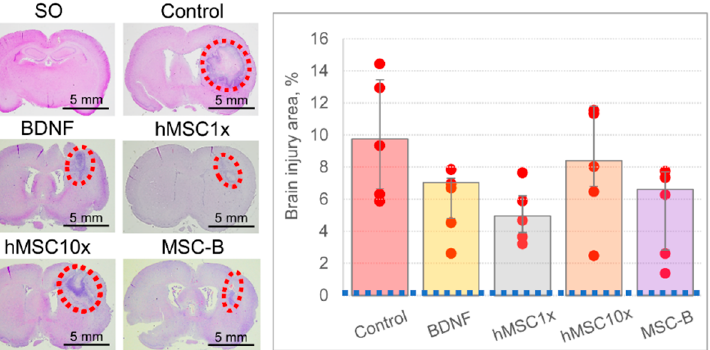
Figure 4. The results of the histochemical examination of the brain at day 14 after the intracerebral hemorrhage. On the photos: the red dashed ovals restrict the injured loci. On the diagram: the blue dashed line equals the area of the brain lesion site in the SO animals. Data is presented as a median (25%; 75%). n = 5; no significant differences between the